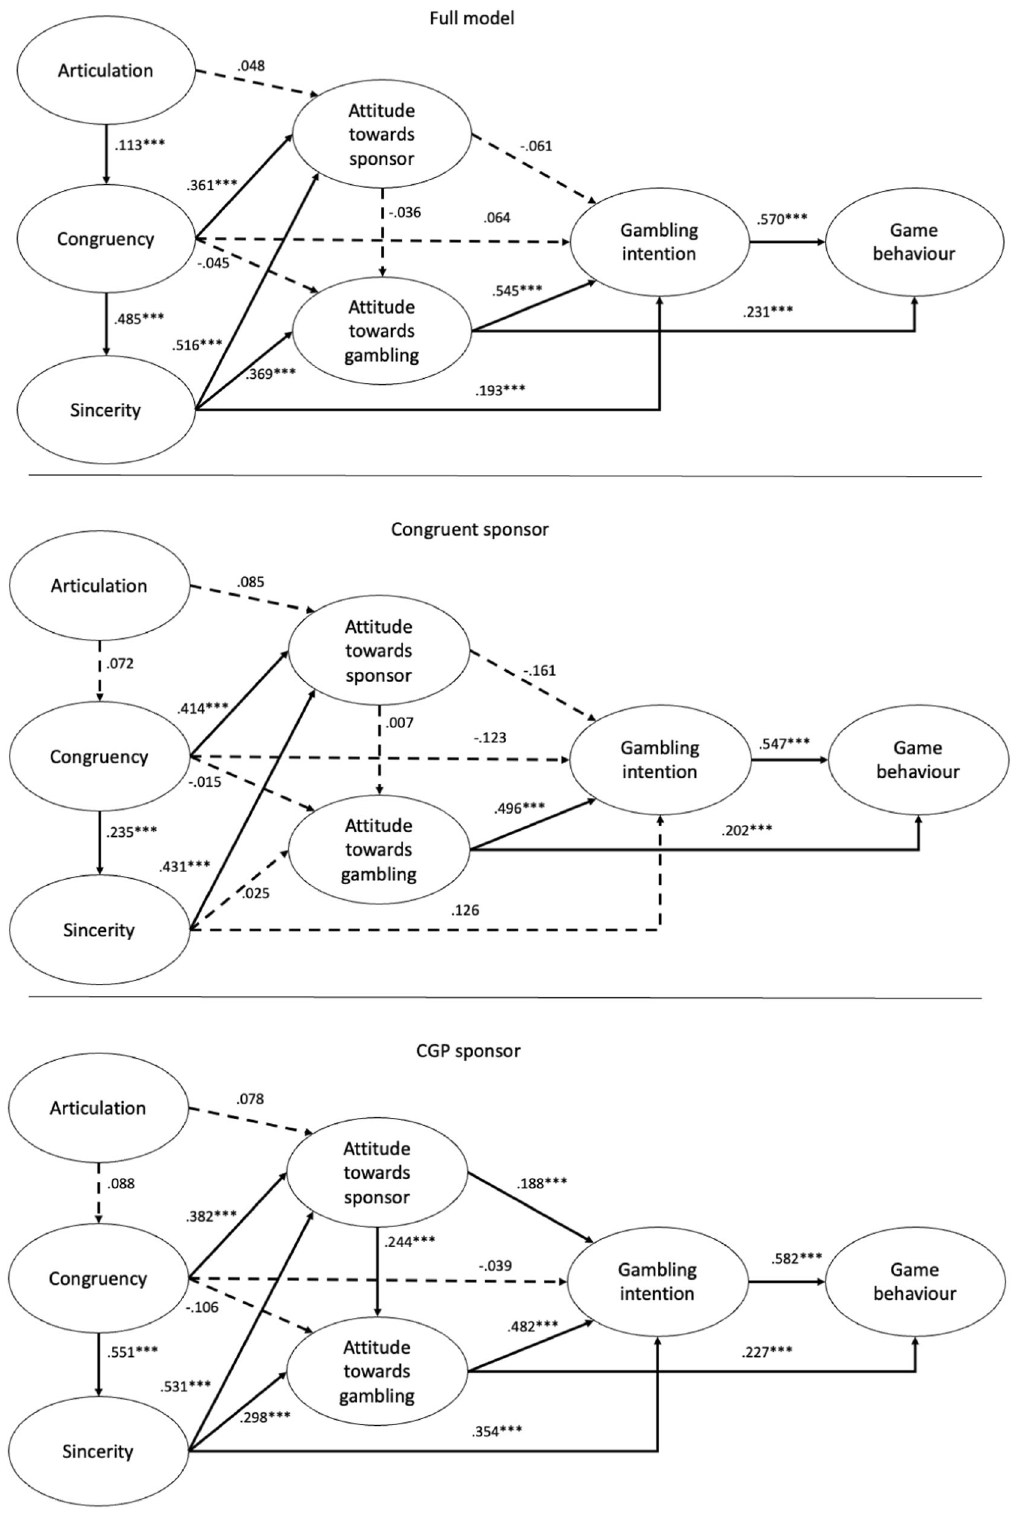
Fig. 2 The full theoretical model is at the top, in the middle part of the image, the model for the congruent sponsor, and at the bottom the model for the CGP sponsor. Note: The solid lines represent the supported hypotheses, and the dashed lines represent the unsupported hypotheses.